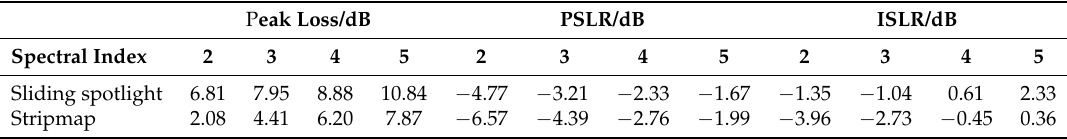
Table 3. The comparison of scintillation effect on point targets between stripmap mode and sliding spotlight mode from Monte-Carlo